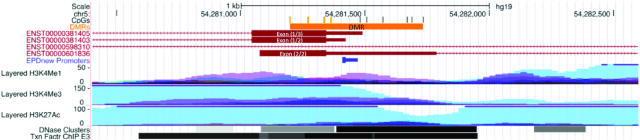
The ESM1 differentially methylated region (DMR) shown within its genomic context and annotated with regulatory features (data tracks from the University of California, Santa Cruz genome browser). The identified DMR overlaps the transcription start site (TSS), 5′ untranslated region, and first exon of the gene and is in an area of active transcription. The tracks show (in order): the chromosomal location; the CpGs making up the region with differentially methylated positions (false discovery rate <5%) in yellow; the ESM1 DMR; Ensembl gene predictions (red); predicted promoter location (blue—Eukaryotic Promoter Database v006); histone tail marks H3K4Me1, H3K4Me3, and H3K27Ac indicating active regions of transcription (on 7 cell lines from ENCODE); DNAse hypersensitivity clusters showing open chromatin (125 cell types from ENCODE version 3); and transcription factor ChIP-seq clusters (ENCODE v3).